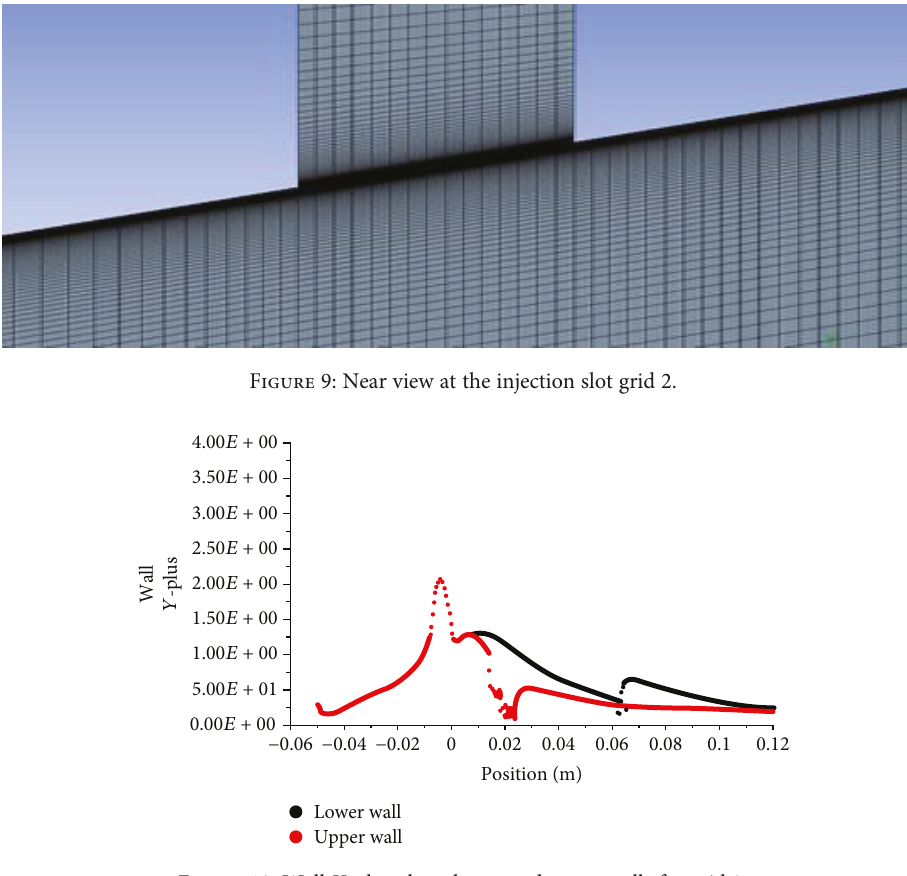
Figure 10: Wall Y -plus along lower and upper walls for grid